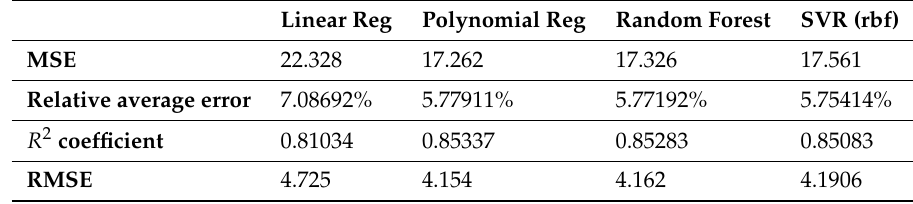
Table 3. First experiment: evaluation coefficients for linear regression, polynomial regression, random forest and Support Vector Machine with rbf